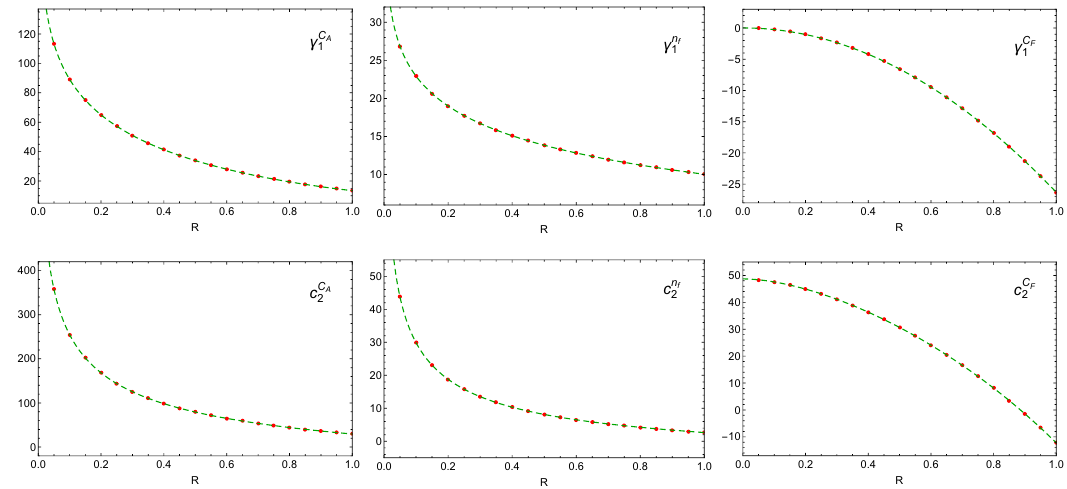
Figure 2. Two-loop anomalous dimension and (cid:12)nite term of the renormalised C-parameter jet-veto soft function. Red dots indicate values calculated with SoftSERVE and green dashed lines represent the interpolating functions from [15].